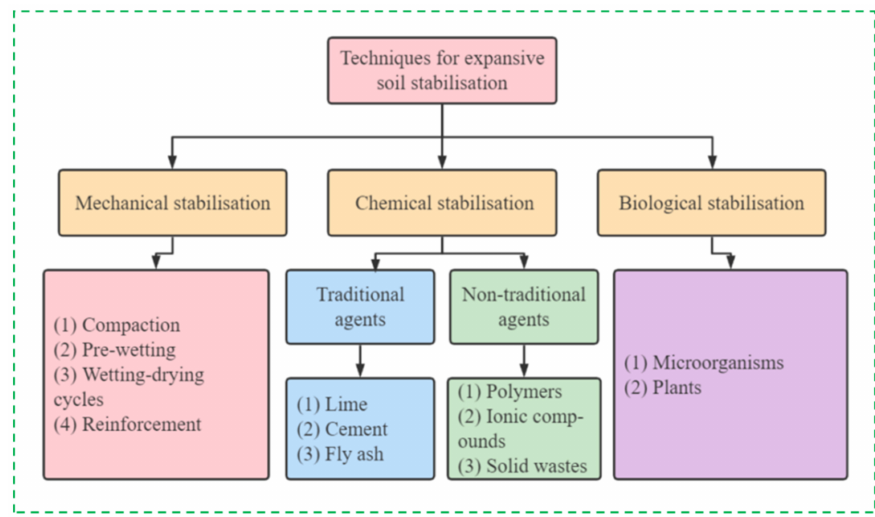
Figure 2. A flow chart of expansive soil stabilization techniques.